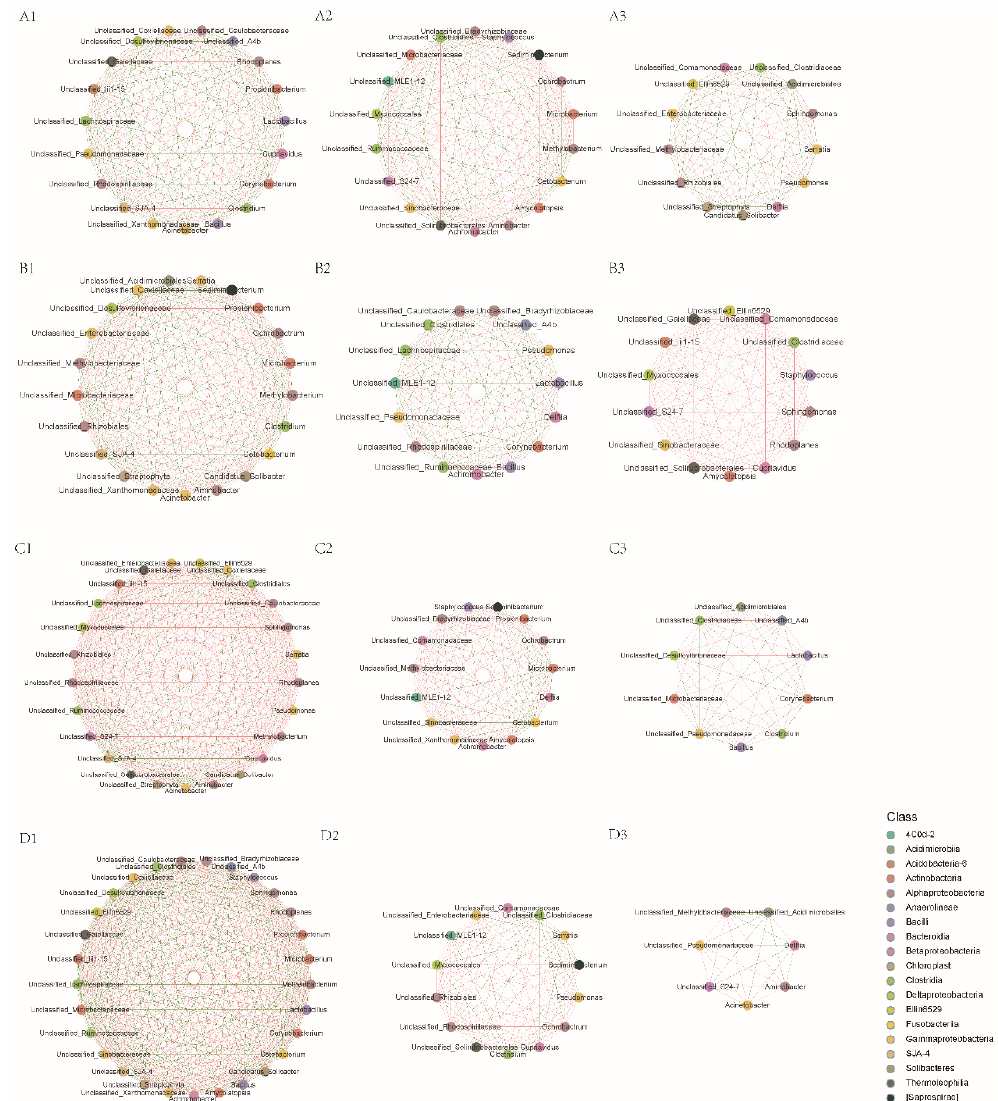
Figure 7. Interspecies interaction network of the intestinal microbiota for O. niloticus among four treatments. Each node represents a bacterial OTU. Node colors indicate OTUs a ffi liated with di ff erent major classes. The green edge indicates negative interaction, and the red edge indicates positive interaction between two individual nodes. ( A1 , A2 , A3 ): freshwater; ( B1 , B2 , B3 ): 16 psu; ( C1 , C2 , C3 ): 16 psu + 0.2% β -glucan; and ( D1 , D2 , D3 ): 16 psu + 0.4% β -glucan. Table 5. Topological properties of the intestinal microbiota co-occurrence network.